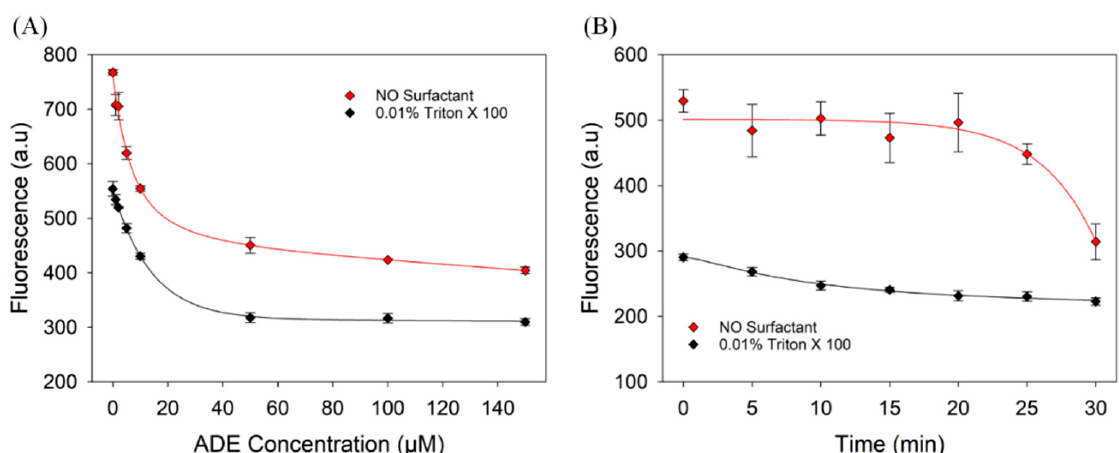
Figure 5. ( A ) Titration curve of 1 µ M adenosine aptamer by adenosine without and with 0.01% Triton X-100. ( B ) Effect of Triton X-100 on signal stability of the adenosine aptamer/ThT system in the presence of 100 µ M adenosine.